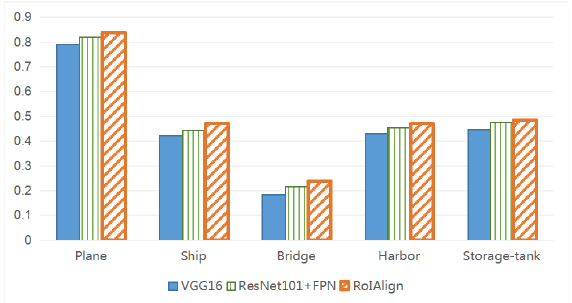
Fig.9 AP of different feature extraction network. (blue: with VGG backbone; green: with ResNet101+FPN; orange: RoIAlign)